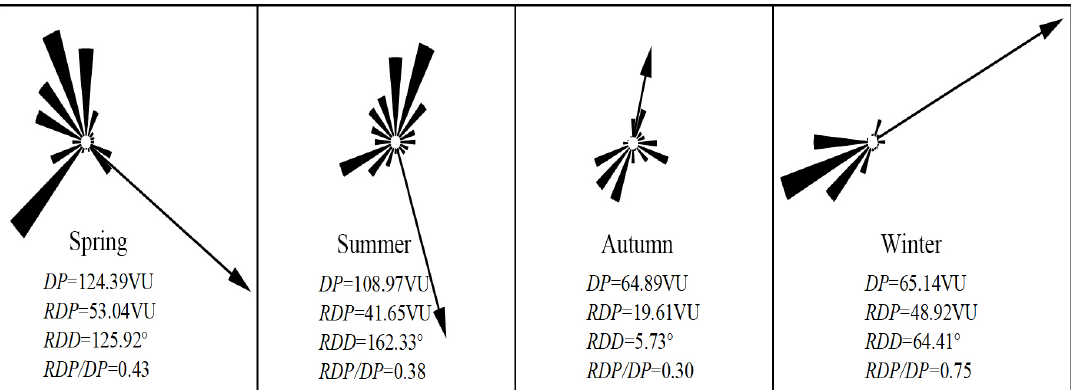
Figure 4. Sand drift potential of each season in the study area.